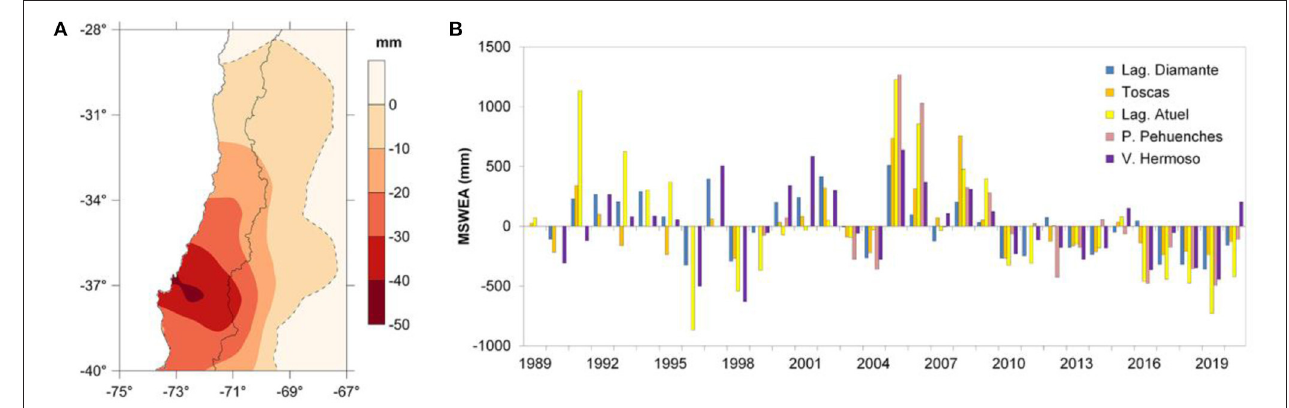
FIGURE 4 | (A) Spatial pattern of the GPCC precipitation anomalies (in mm/month) during the months of April to October of the years 2010-2020, based on the 1981-2010 climatology. (B) Temporal evolution of MSWEA in the five selected snow pillow stations, calculated as departures from the period 1990–2020.